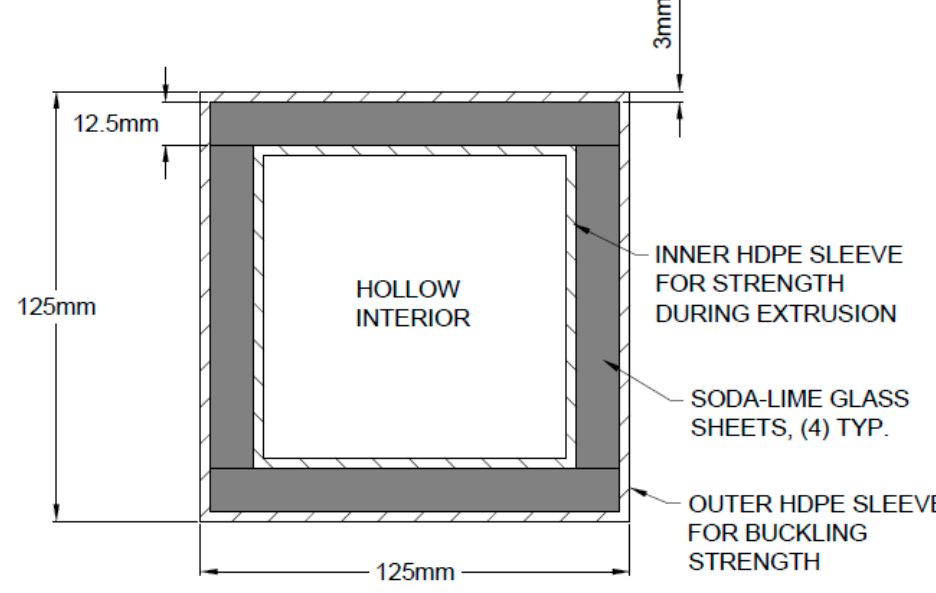
Figure 10. The cross-section of the selected GRCC for equivalent buckling load as an HSS 5 × 5 × 1/8.